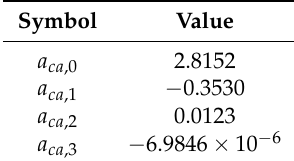
Table A2. CA pressure drop